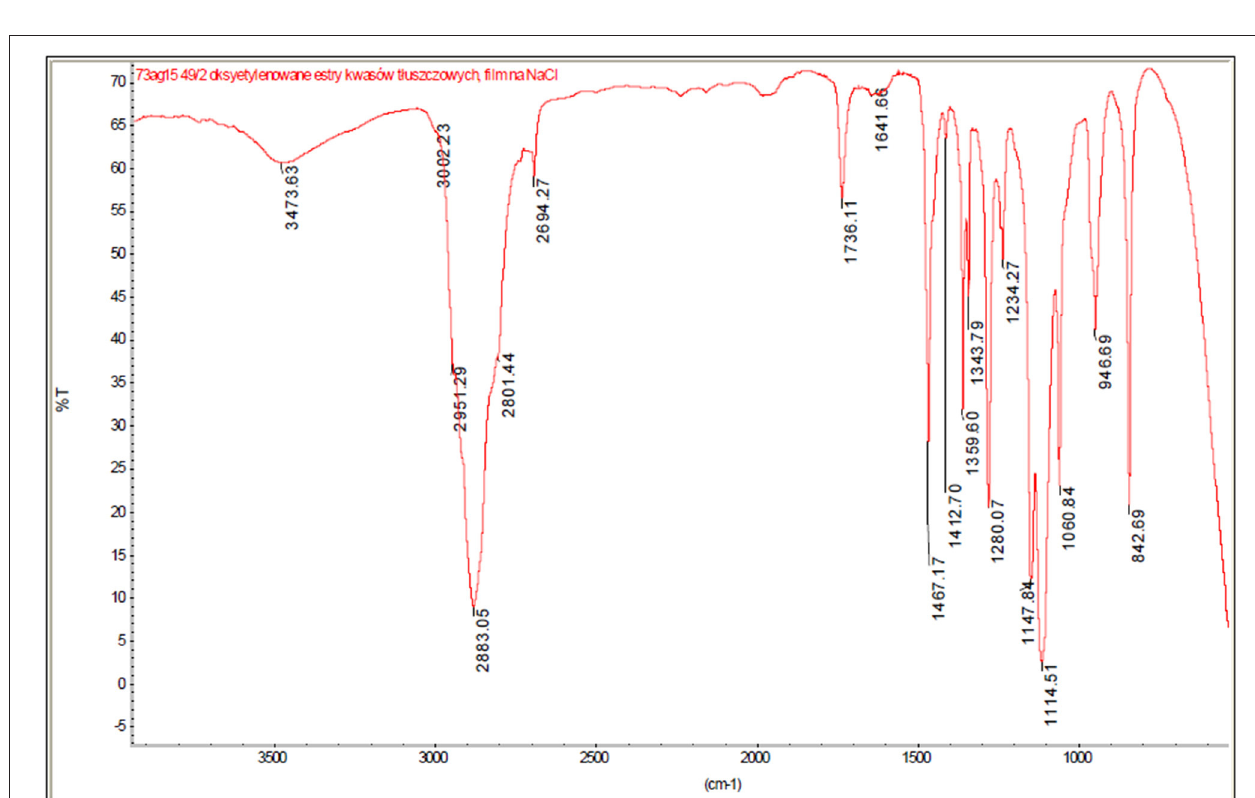
FIGURE 3 | Exemplary FT-IR spectrum of the RME sample (N AV =